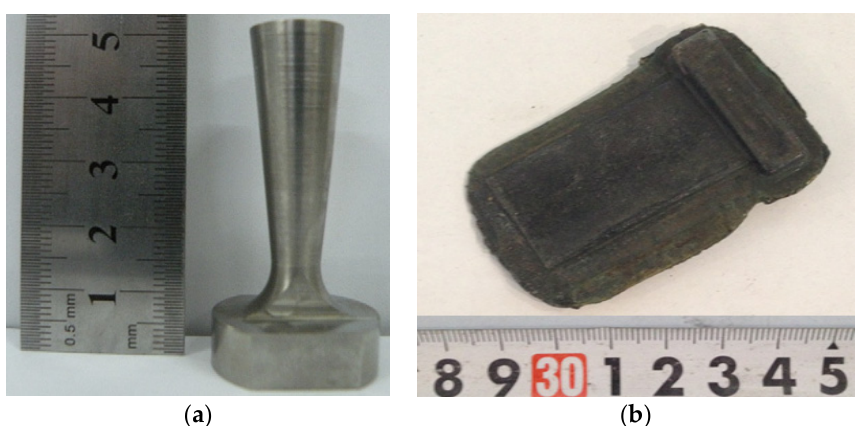
Figure 7. Images of ( a ) initial billet and ( b ) high Nb–TiAl blade forged by the isothermal-die.